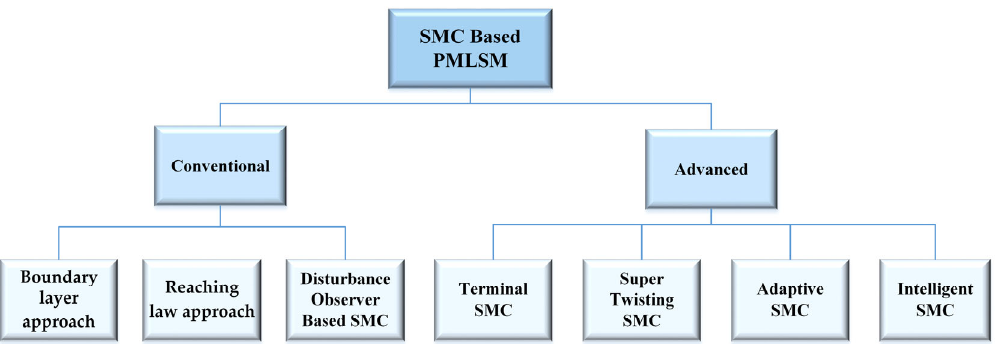
Figure 4. Block diagram of the SMC-based PMLSM position control scheme.